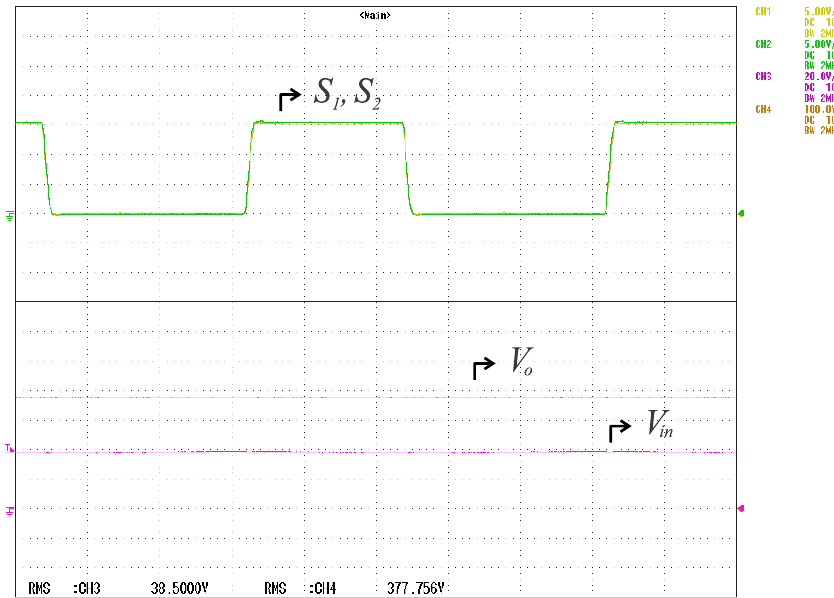
Figure 6. Top: switches gate signals v gs 1 and v gs 2 (5 V/div); bottom: input voltage v in (20 V/div) and output voltage v o (100 V/div).